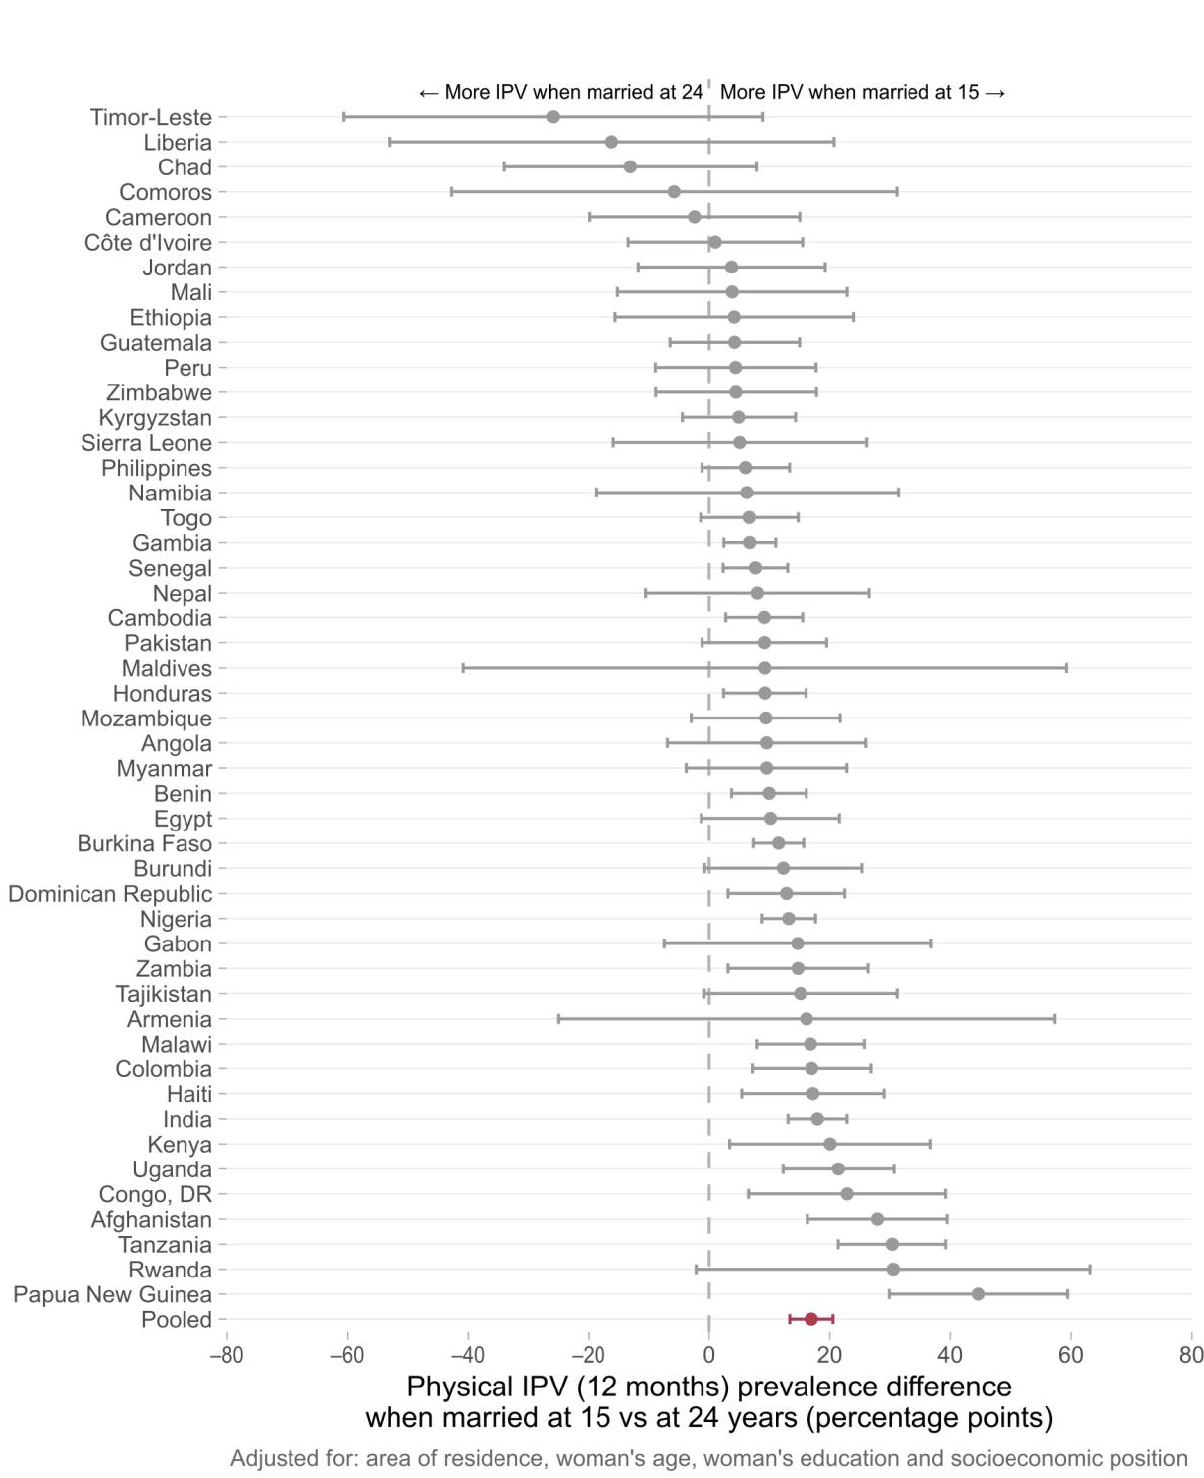
Figure 2. Difference between the average physical IPV prevalence among women aged 20–24 years first married at 15 years and at 24 years of age. Individual results for 48 low- and middle-income countries obtained from logistic regression models. The pooled estimate of the prevalence difference in past year physical IPV (in red) was 16.9 percentage points (95% CI 13.3 – 120.5).